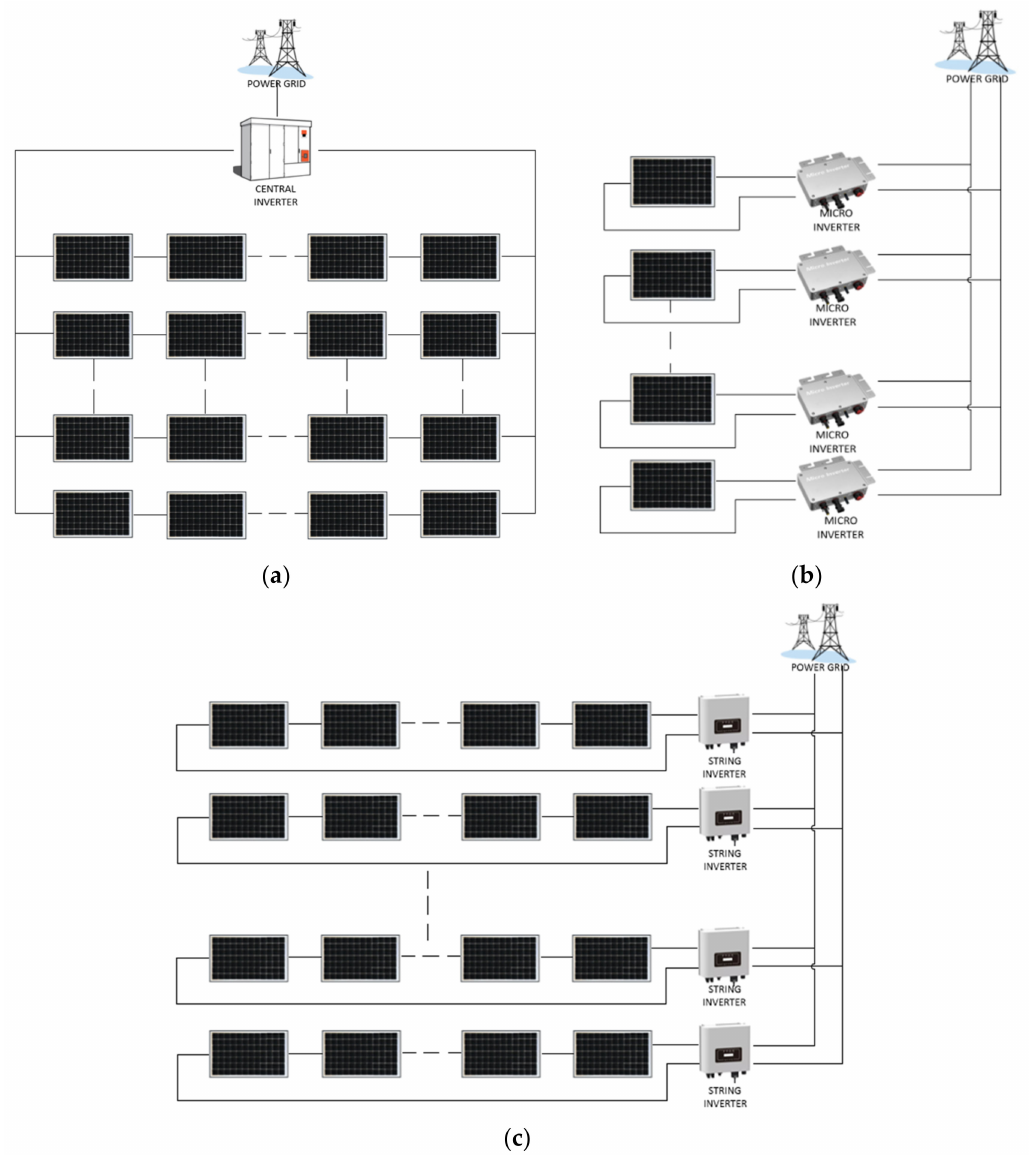
Figure 1. Configurations of PV system: ( a ) Centralised system; ( b ) Detached microinverter system; ( c ) String system